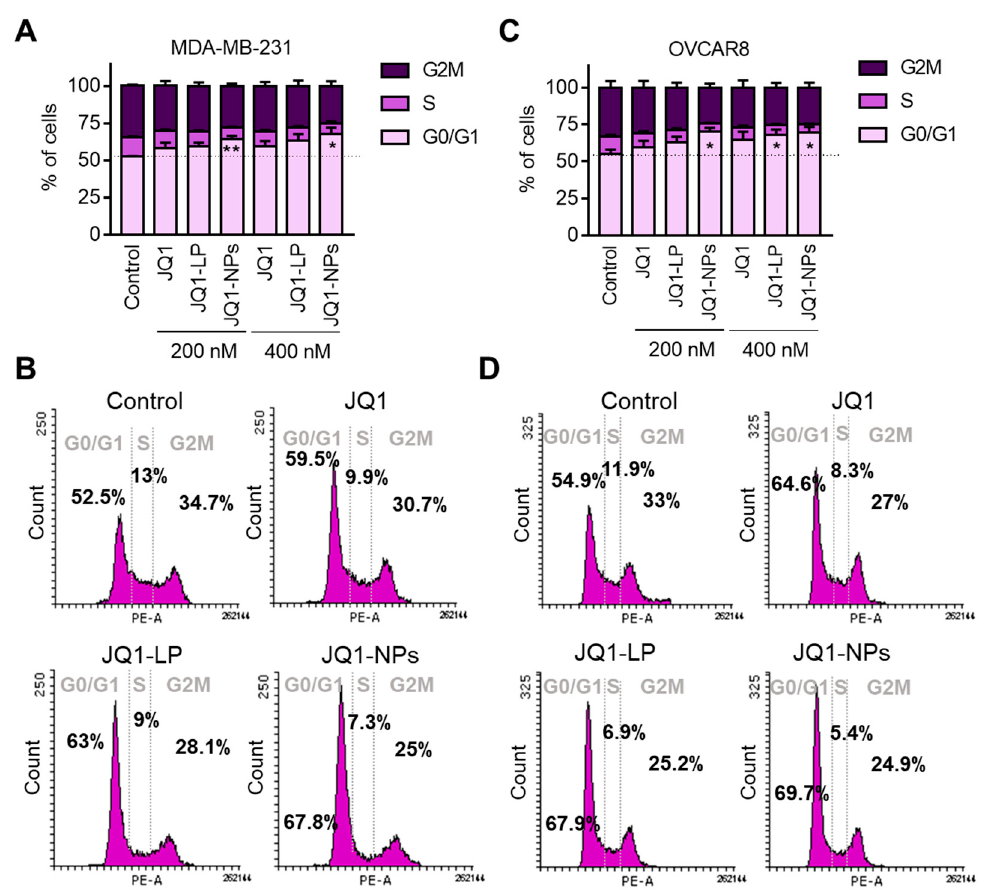
Figure 7. Cell cycle analyses show free JQ1 and JQ1 encapsulation increased G0/G1 phase arrest. MDA-MB-231 breast cancer cells ( A ) and OVCAR8 ovarian cancer cells ( C ) were treated for 24 h with 200 or 400 nM of JQ1 (free), JQ1 liposomes and JQ1 nanoparticles. Later, cells were fixed and stained with PI for cell cycle evaluation. ( B , D ) Histogram representing the percentage of cells in each cell cycle phase after each treatment (400 nM). * p ≤ 0.05, ** p ≤